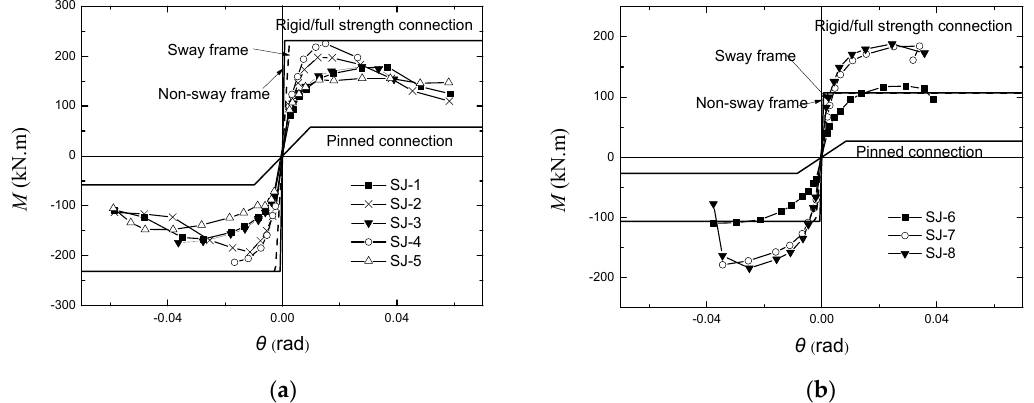
Figure 16. Classification of the specimens. ( a ) Specimens SJ-1 through SJ-5; ( b ) Specimens SJ-6 through SJ-8.